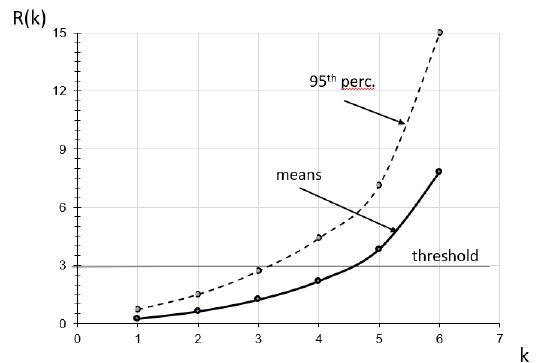
Figure 8. Mean response times and 95th percentiles for the computation of the best route waiting at the Join the first k algorithms that completed their executions.